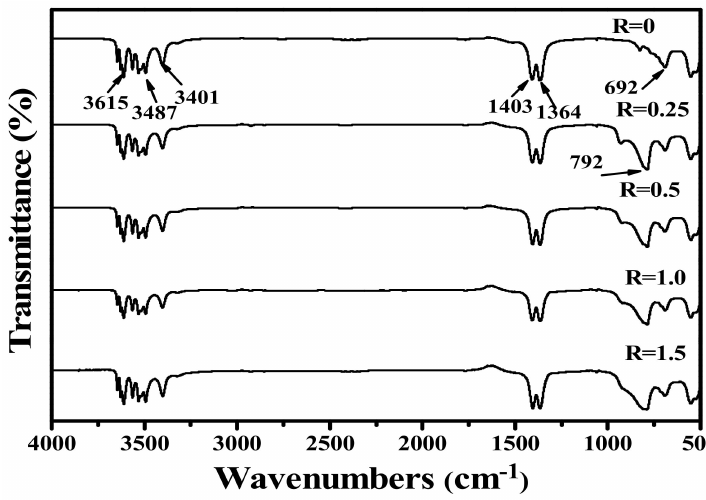
Figure 4. FT-IR spectra for MC ( R = 0) and MC- R M after the reaction with VO 3 −